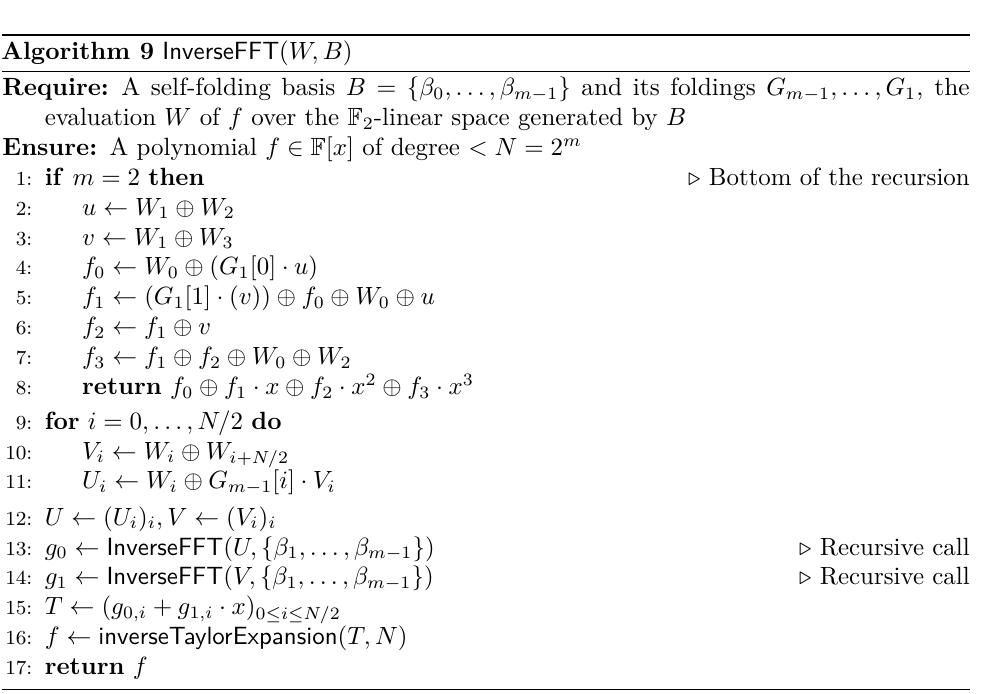
Algorithm 9 InverseFFT ( W, B